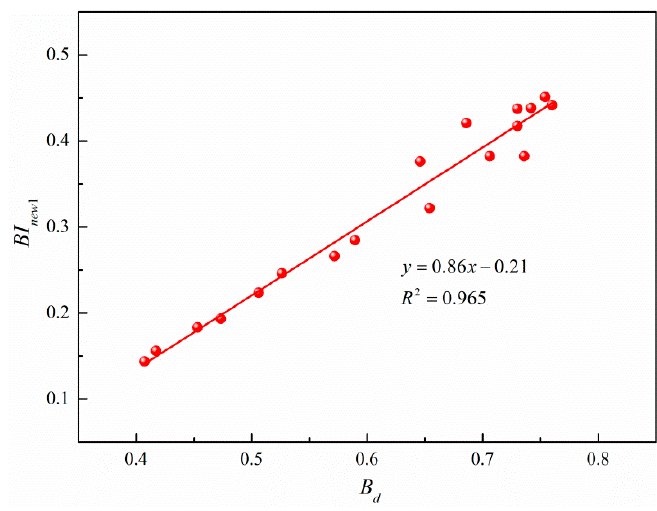
Figure 10. Correlation between BI new 1 and B d of glutenite under uniaxial and triaxial stress.